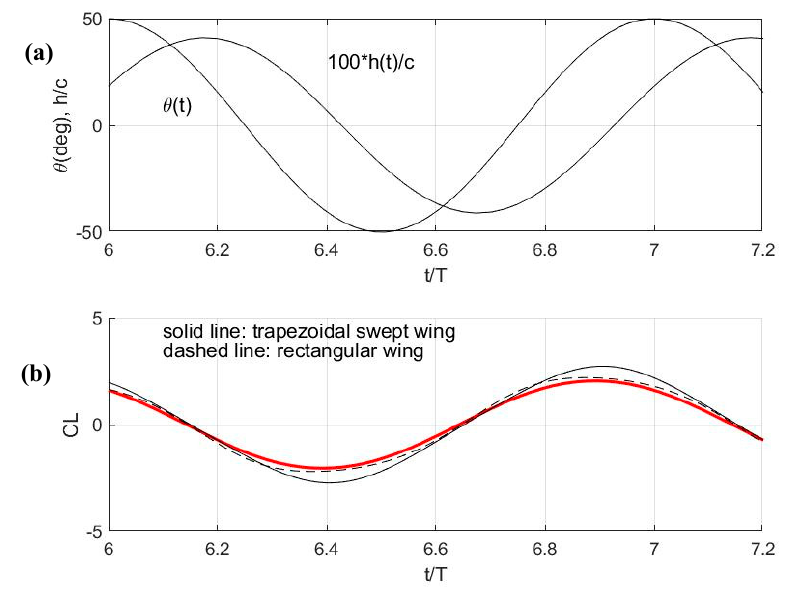
Figure 10. Calculated history of lift coefficient for 3D wings (rectangular, swept back). ( a ) Enforced oscillatory transverse (heave) motion h / c and self-pitch θ motion corresponding the data of Figure 4. ( b ) Calculated C L coefficient from 3D vortex element method for rectangular (dashed line) and trapezoidal swept-back wing (solid line), and comparison with the prediction by the present semi-3D model Equation (4) shown by using red line.